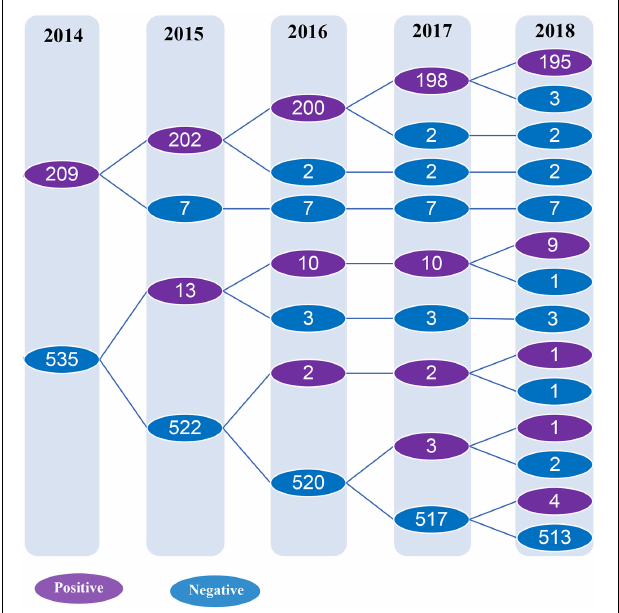
FIGURE 2 | Detection of anti- C. trachomatis Pgp3 antibody from 2014 to 2018. The subjects included in the longitudinal cohort study were followed up and tested for anti-Pgp3 antibody annually. The purple circle indicates the number of anti-Pgp3 antibody positive subjects, while the blue circle represents the number of anti-Pgp3 antibody negative